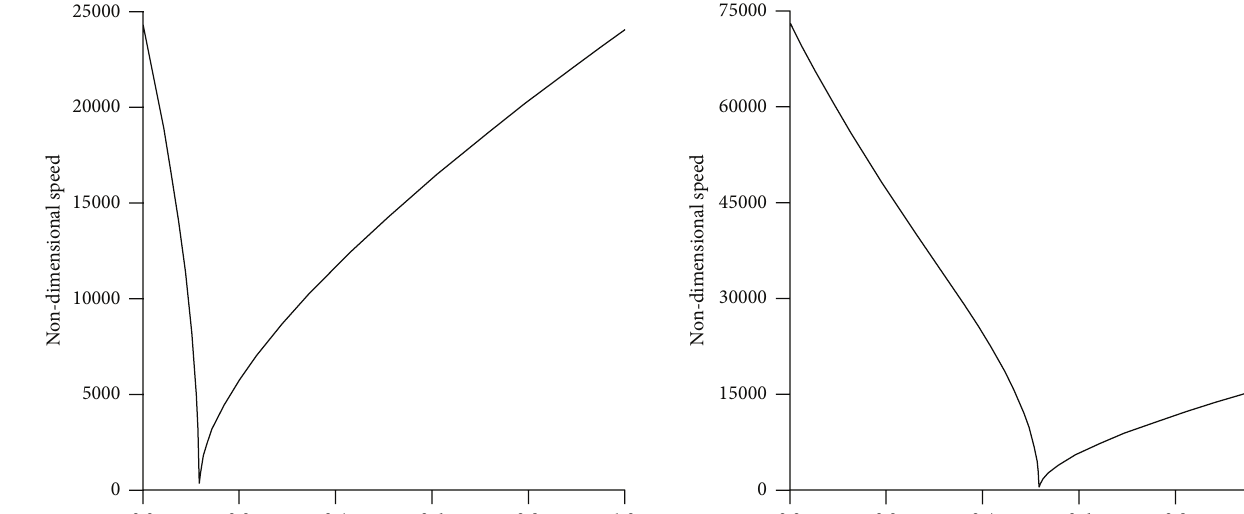
Figure 3: Variation of the nondimensional speed (𝜌𝑐 2 /𝜇) Rayleigh wave versus microtemperature constant 𝐾 4 .